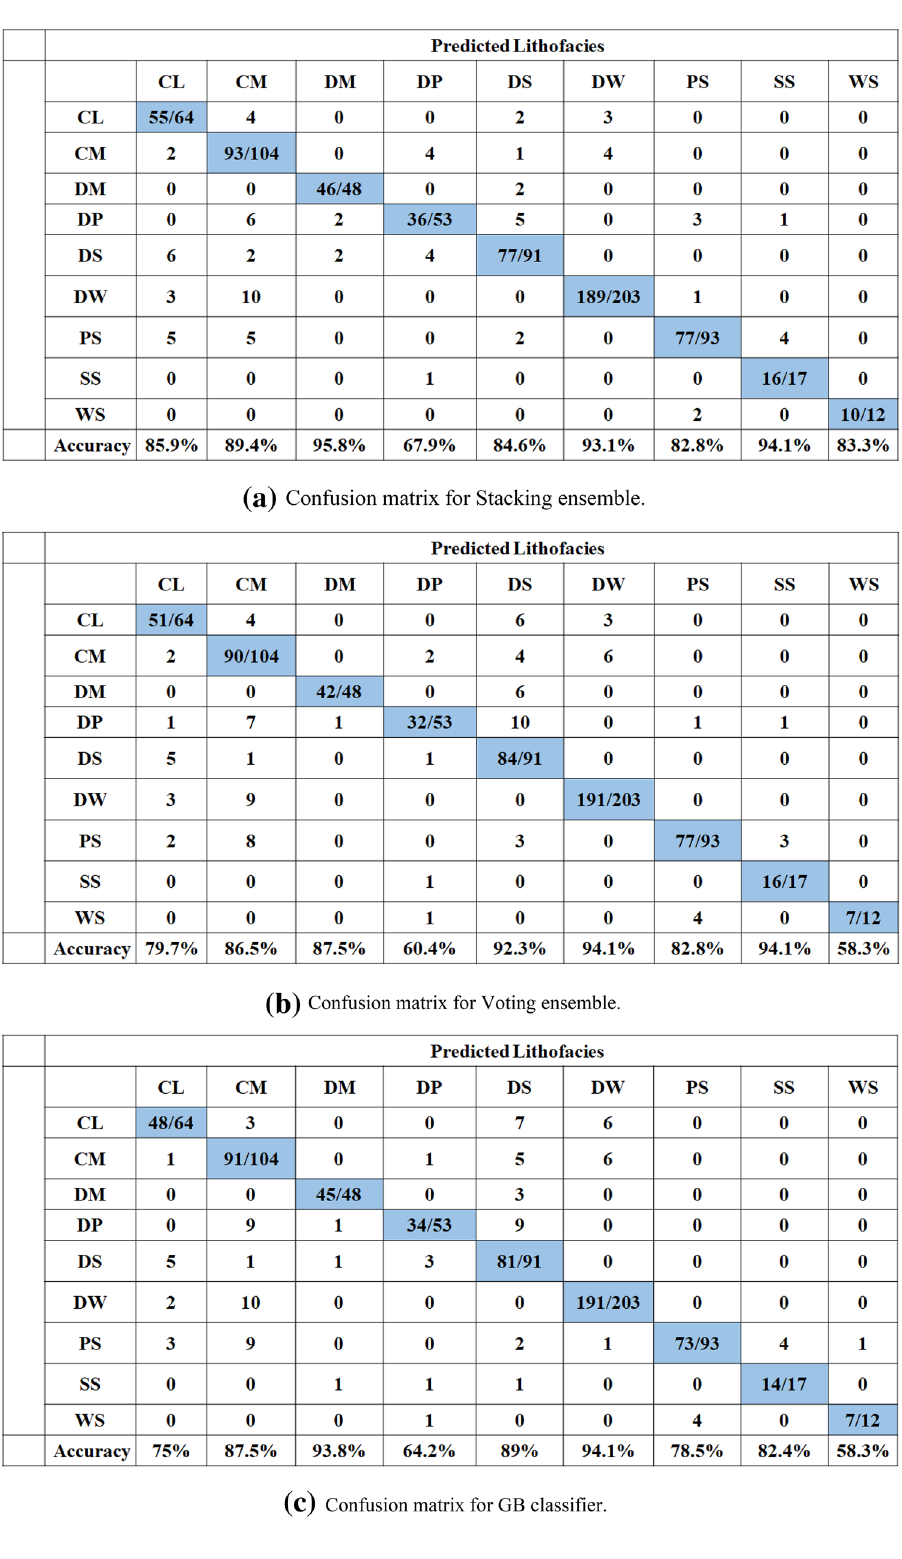
Fig. 11 Confusion matrices for different classifiers using 20% of input data as a testing dataset to predict different